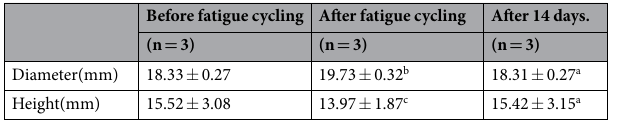
Table 1. Sample Diameter and Height before and after fatigue cycling and after 14 days. a Statistical analysis showed that the height and diameter difference was not significant (p = 0.149,p = 0.073) before fatigue cycling and after 14 days. b Statistical analysis showed that the diameter difference was significant (p = 0.006) before and after fatigue cycling. c Statistical analysis showed that the height difference was not significant (p = 0.194) before and after fatigue